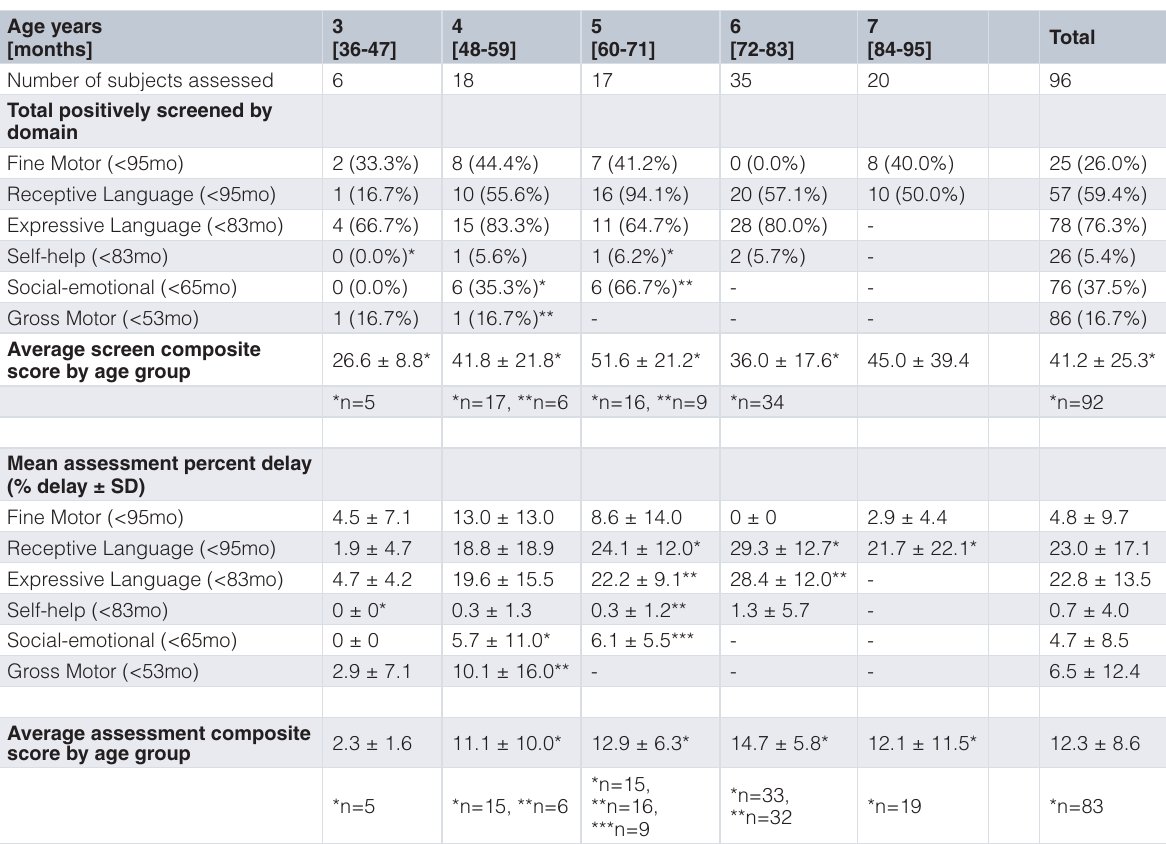
Table 3. Parental Evaluation of Developmental Status: Developmental Milestones (PEDS:DM) results. “Total positively screened” refers to the number of children by age group who screened positive in any single domain. The average screen composite score represents the number of domains failed over the number of domains assessed. The mean assessment is a measure of the mean percent delay across a single domain, while the average assessment composite score measures the mean percent delay across all of the domains